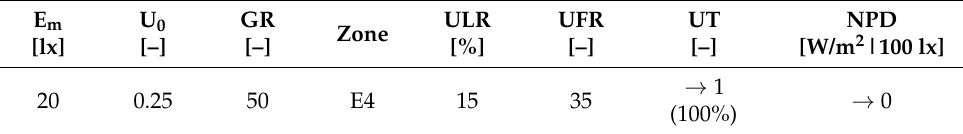
Table 2. Settled requirements for particular